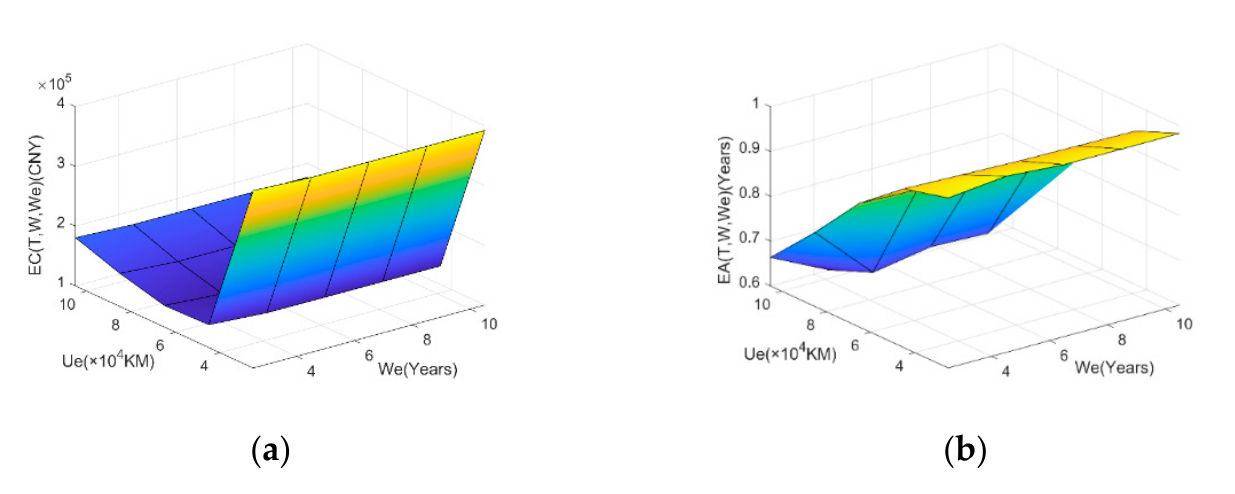
Figure 11. Dimension reduction analysis when T was fixed. ( a ) Warranty cost as a function of the two-dimensional warranty period. ( b ) Availability as a function of the two-dimensional warranty period. Table 6. The optimal 2D EW scheme (unit: years). U e /×10 4 KM